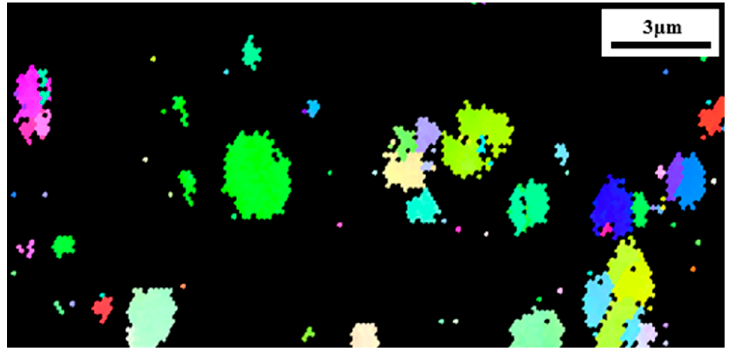
Figure A1. Abnormal grain growth occurring in the FCC phase. The EBSD map shows abnormal grain growth occurring during annealing at 673 K (400 °C) for 1 min in the electroformed Fe-43 wt % Ni alloy consisting of the single γ′ phase. The dark area indicates the nanometer-sized crystallites smaller than the step size of the EBSD scanning.